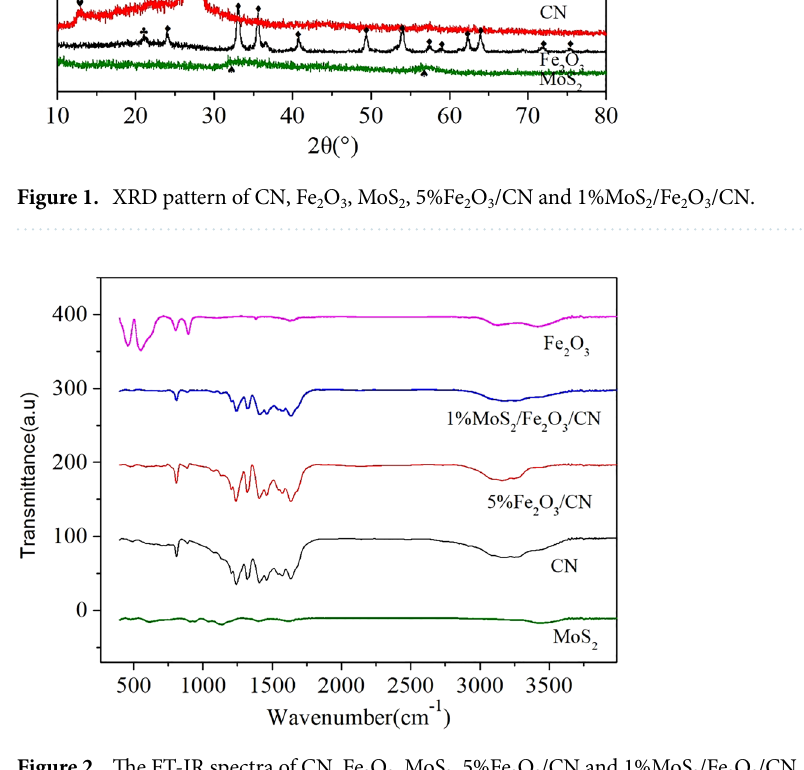
Figure 2. The FT-IR spectra of CN, Fe 2 O 3 , MoS 2 , 5%Fe 2 O 3 /CN and 1%MoS 2 /Fe 2 O 3